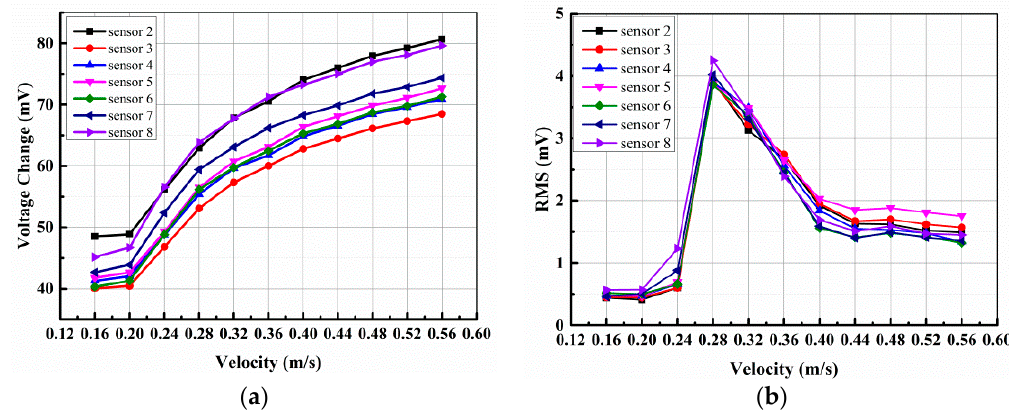
Figure 13. ( a ) Voltage change and ( b ) RMS value of all seven sensors.